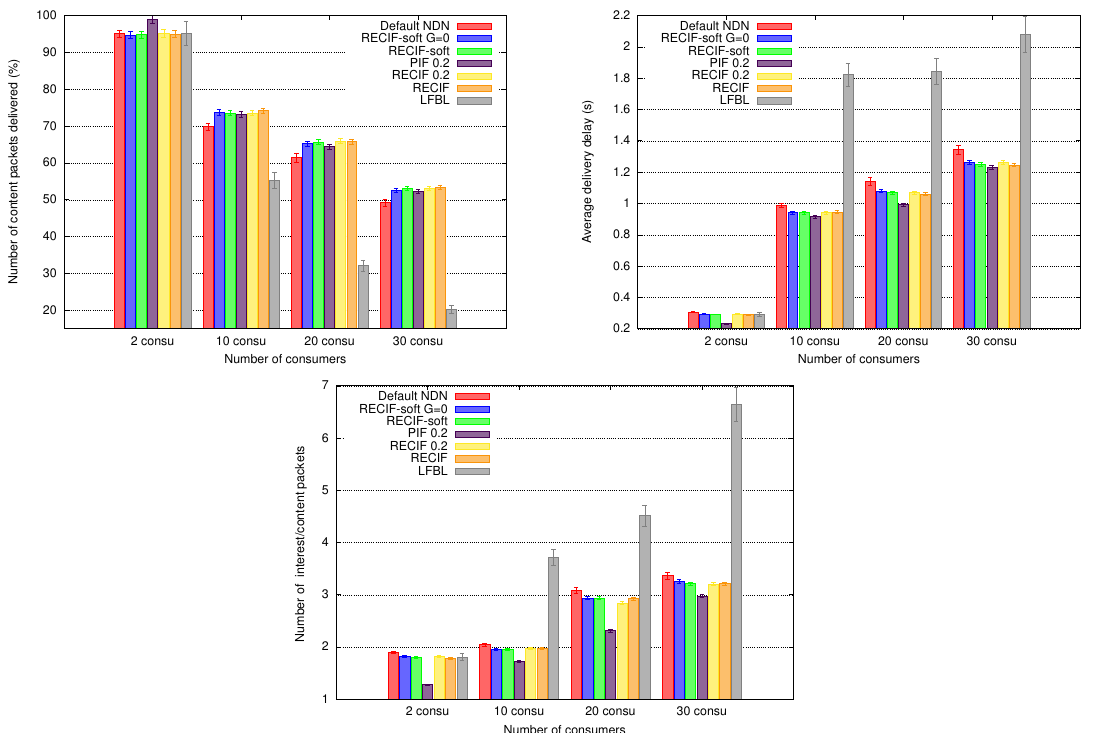
Figure 9. Content packets delivered, average delivery delay and overhead for 2, 10, 20 and 30 consumers requesting popular content at 50